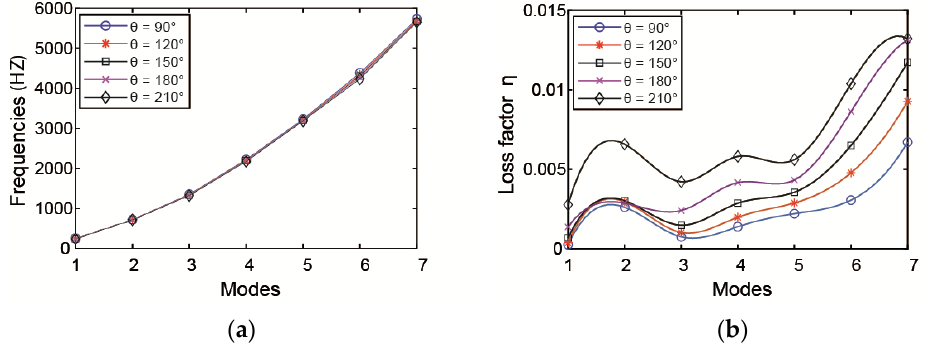
Figure 6. Influence of θ on the ( a ) modal frequency and ( b ) loss factor.